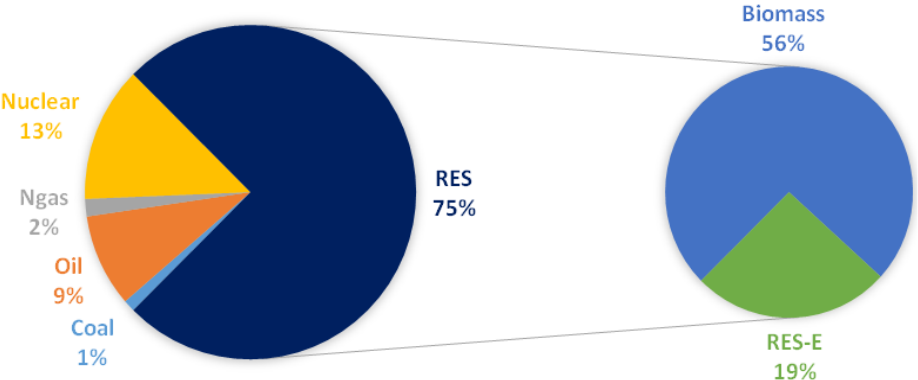
Figure 24. Fuel consumption in the Finnish scenario with 75% RES.